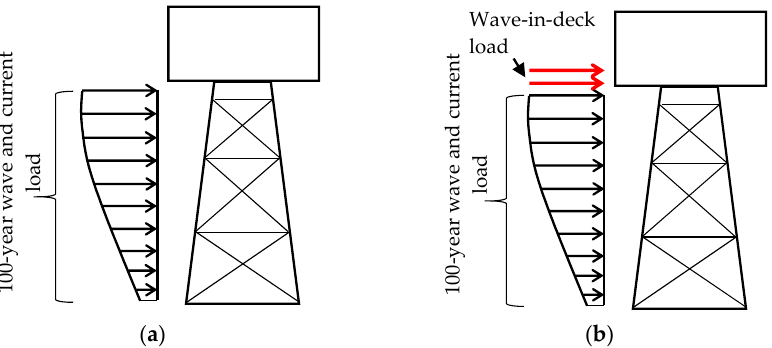
Figure 3. Comparison of the conventional method of limiting the 100-year wave and current load with the inclusion of wave-in-deck load: ( a ) conventional method; ( b ) with inclusion of wave-in-deck load.